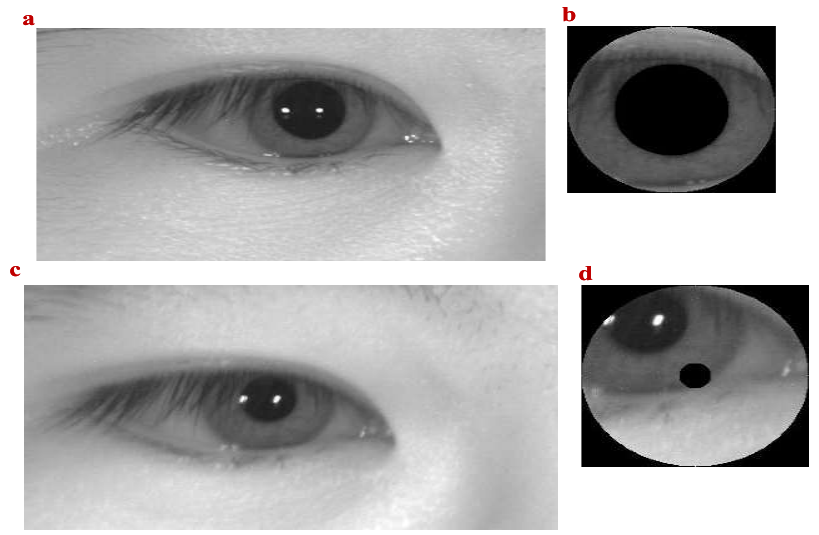
Figure 6. Influence of blurred eye image on iris segmentation ( a ) Clear eye area with 701 × 401; ( b ) Correct iris segmentation; ( c ) Blurred eye area; ( d ) Wrong iris